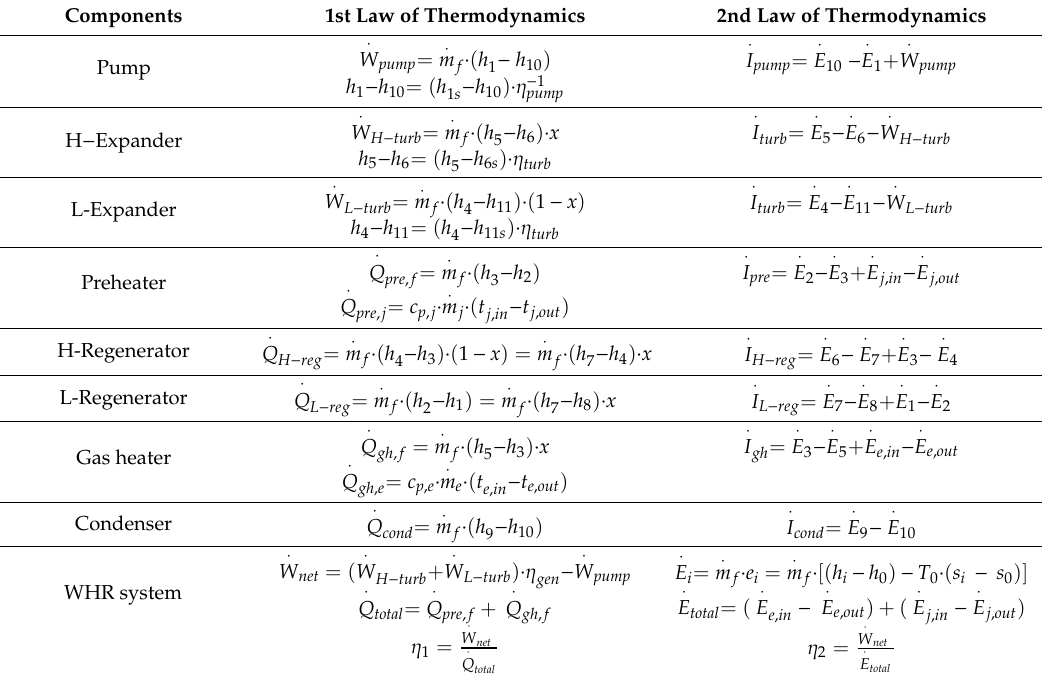
Table 4. Basic thermodynamic modeling. WHR: waste heat